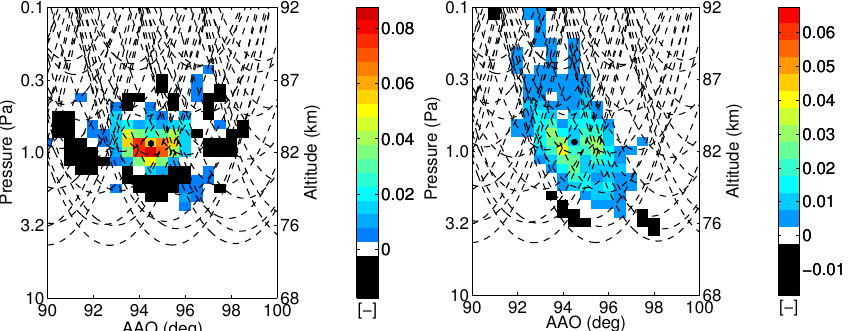
Figure 9. The 2-D averaging kernel of water vapour (left) and temperature (right) for the retrieval grid point marked by the black dot. The dashed lines show the line-of-sight of the measurements through the